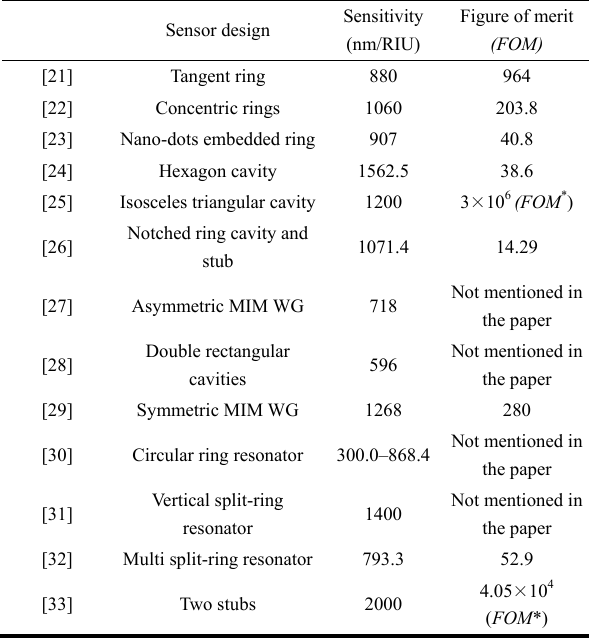
Table 1 Recently proposed MIM WG based